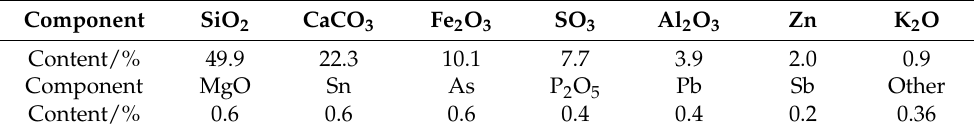
Table 1. Chemical components of the sample.